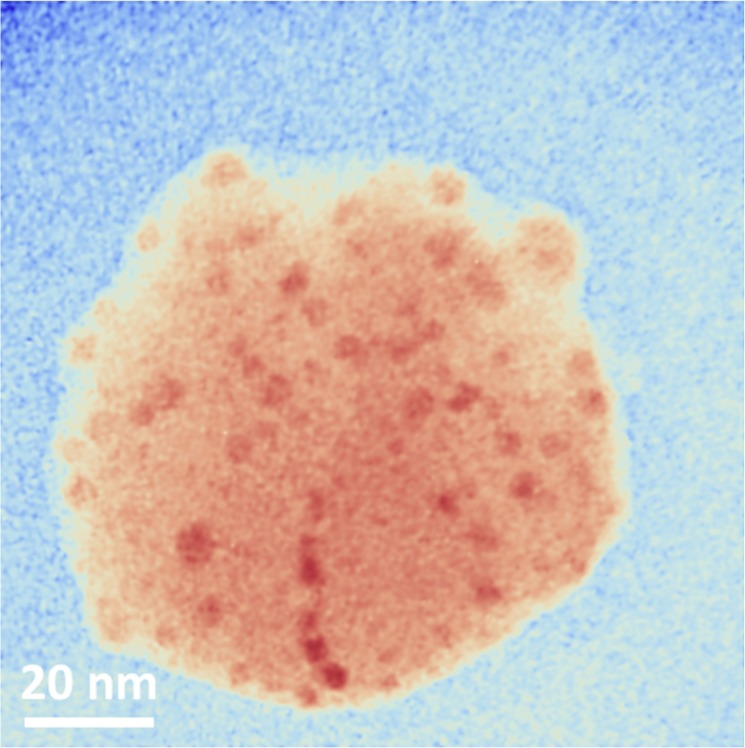
Representative HRTEM image for nanoparticles covering the fiber.Representative HRTEM image in a false color output of one of the big nanoparticles covering the TS fiber. Note the small dark particles, with diameters between 2nm and 6nm, inside.